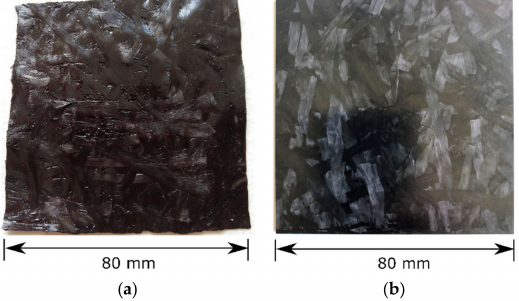
Figure 1. As-delivered ( a ) and pressed ( b ). C-SMC (carbon-fiber sheet molding compound) sheet: carbon-fiber sheet mold compound “Polynt SMCarbon 80 CF60-3K / 2”